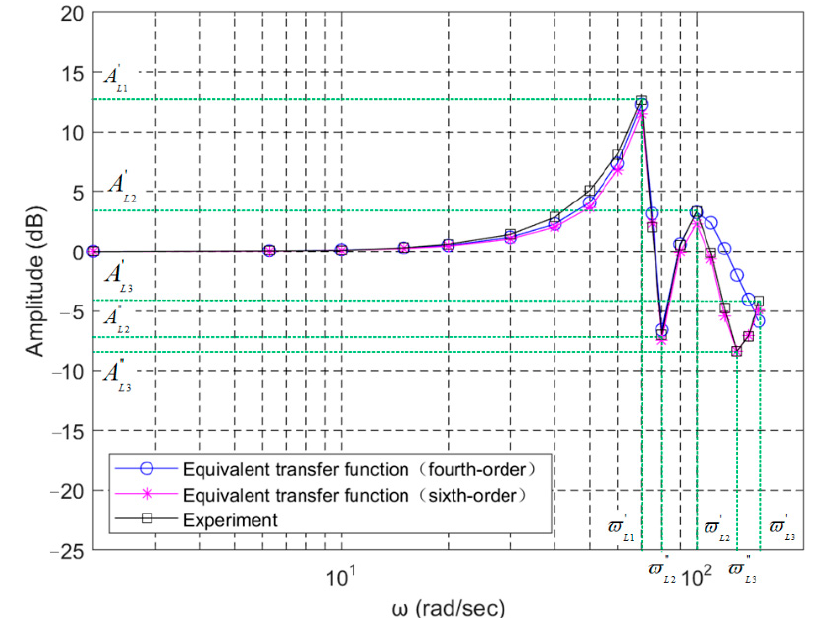
Figure 15. The structural dynamics of a kerolox launcher engine.